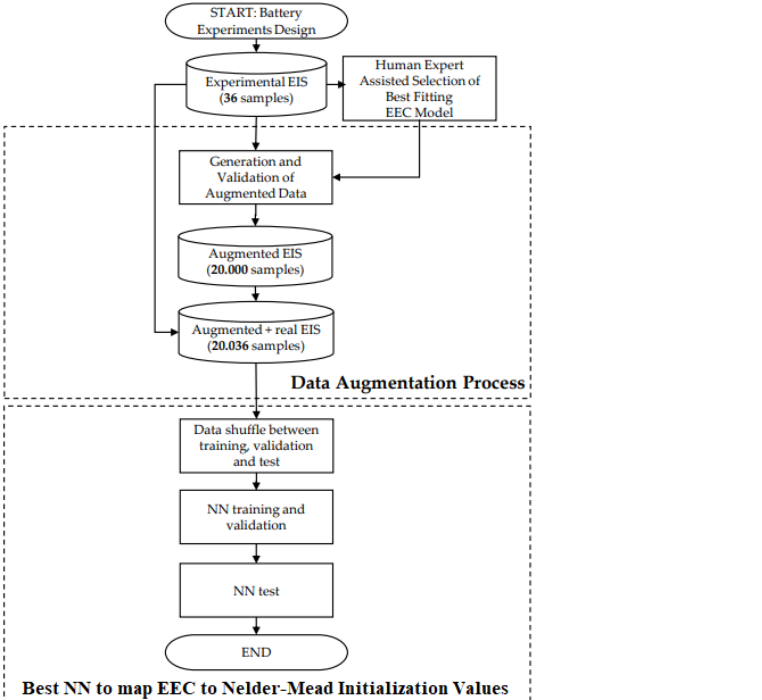
Figure 4. Flow-chart processes for ( a ) data augmentation and ( b ) best NN selection to map EIS to the Nelder – Mead Initialization values.